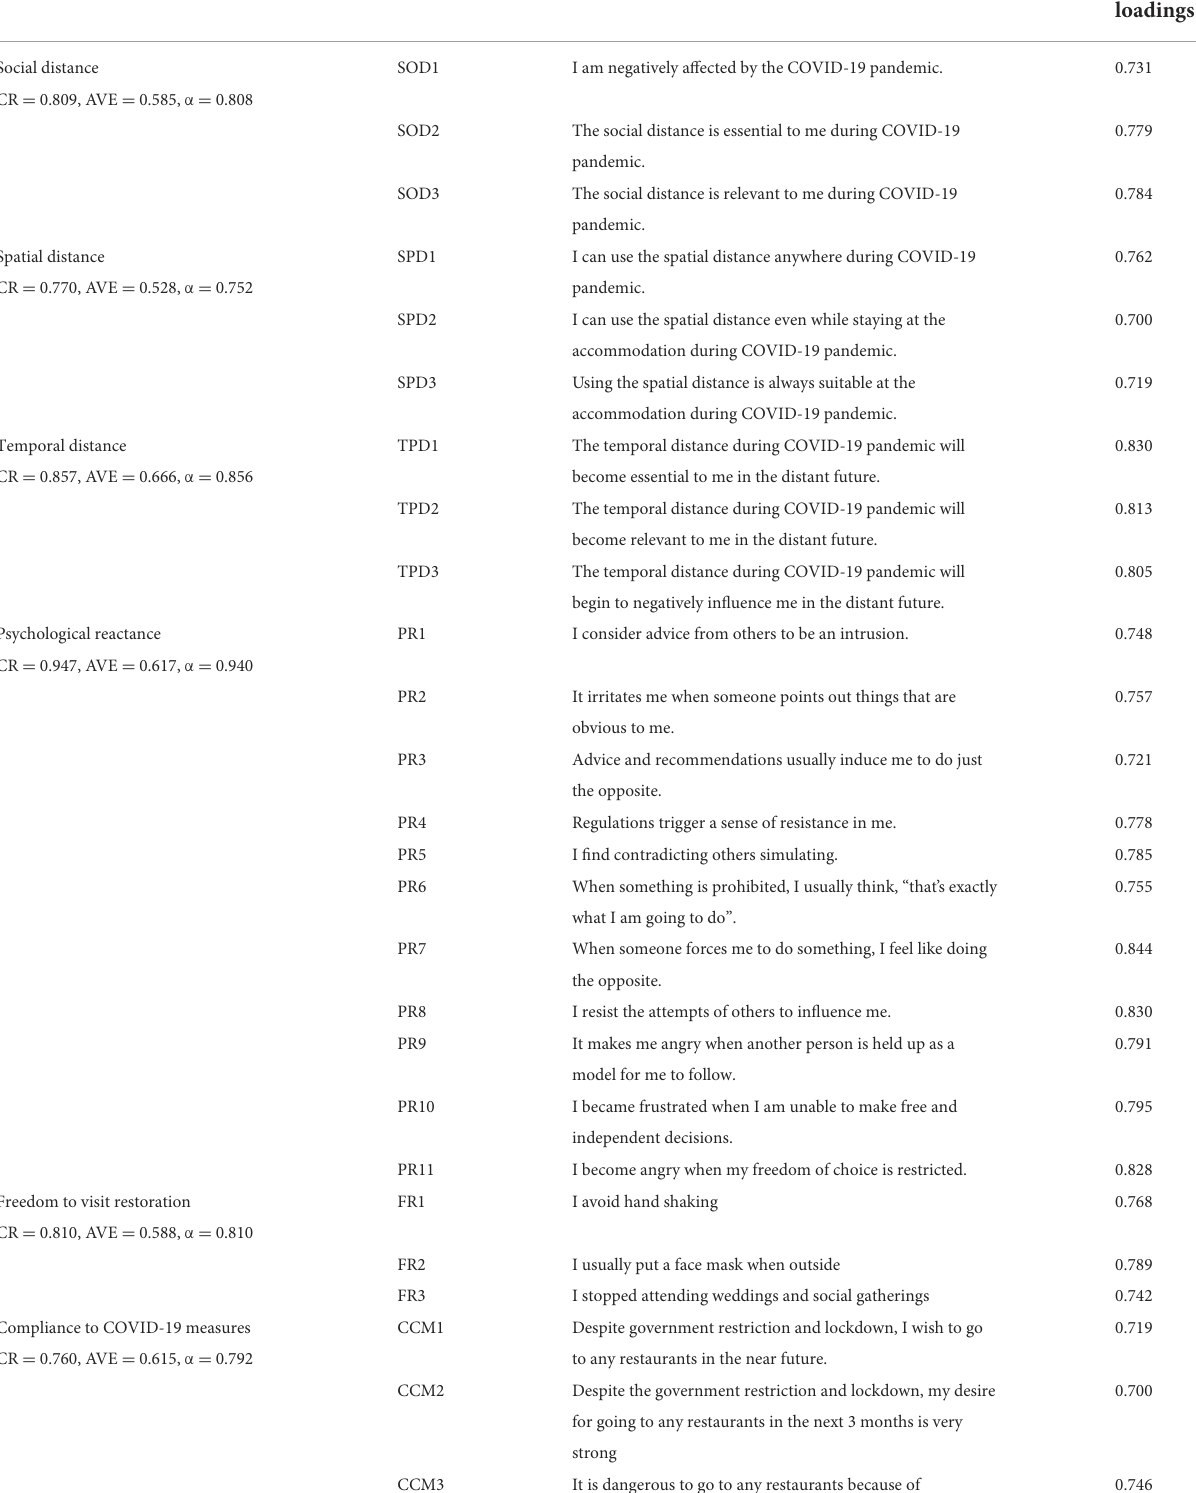
TABLE 2 Factor loadings of confirmatory factor